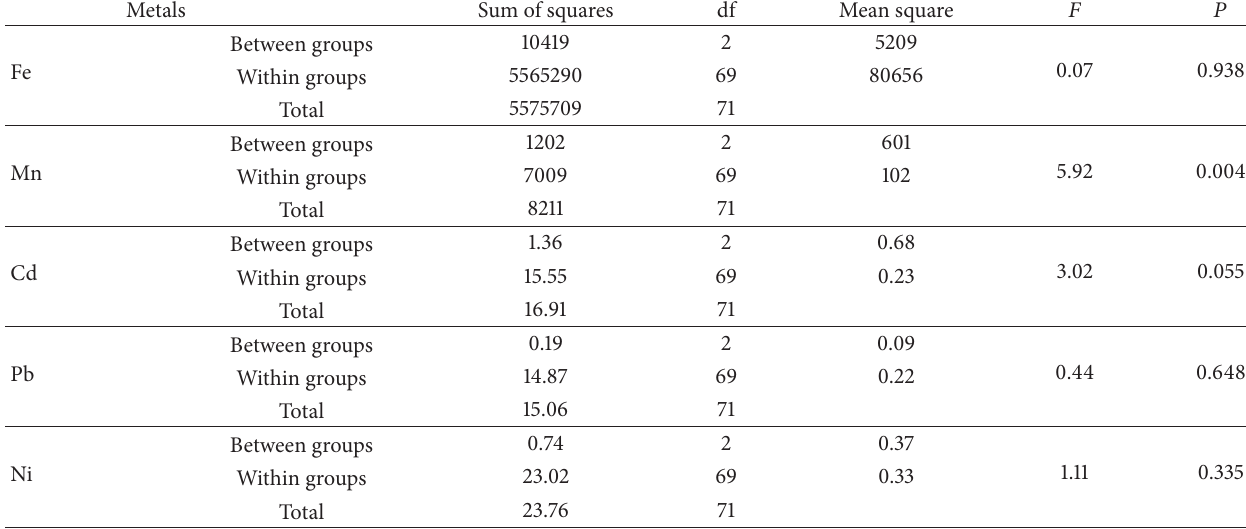
Table 2: Analysis of variance (ANOVA) of heavy metals in Terapon puta collected at Karachi Fish Harbor from January 2012 to December